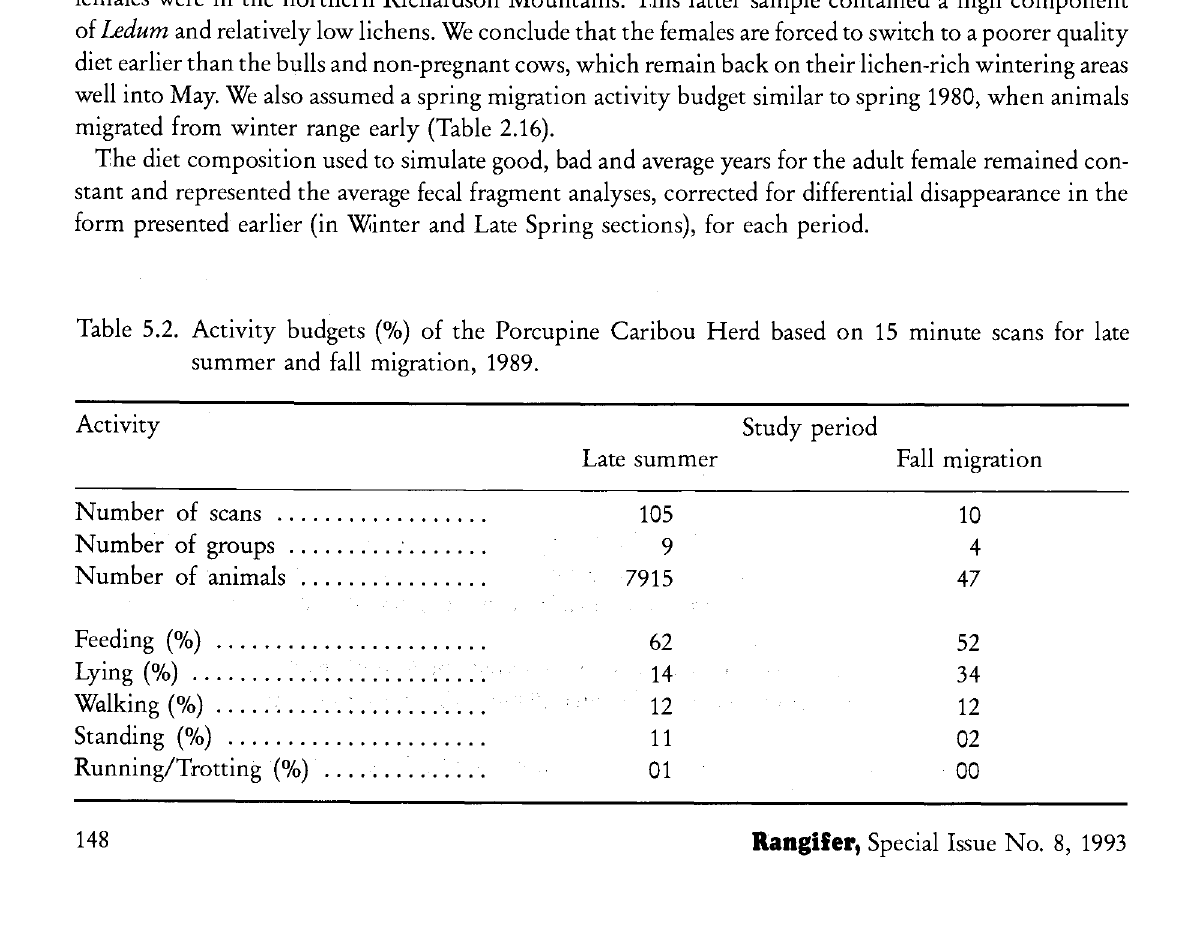
Table 5.2. Activity budgets (%) of the Porcupine Caribou Herd based on 15 minute scans for late summer and fall migration,